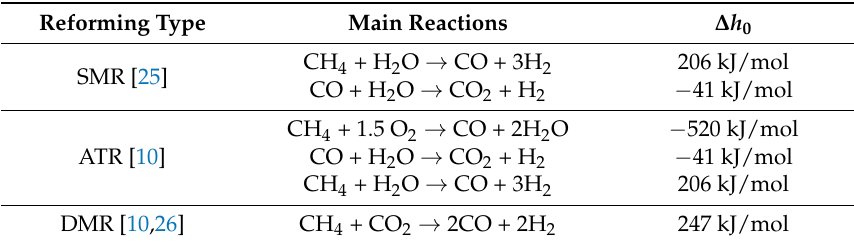
Table 1. Overview of the main reforming